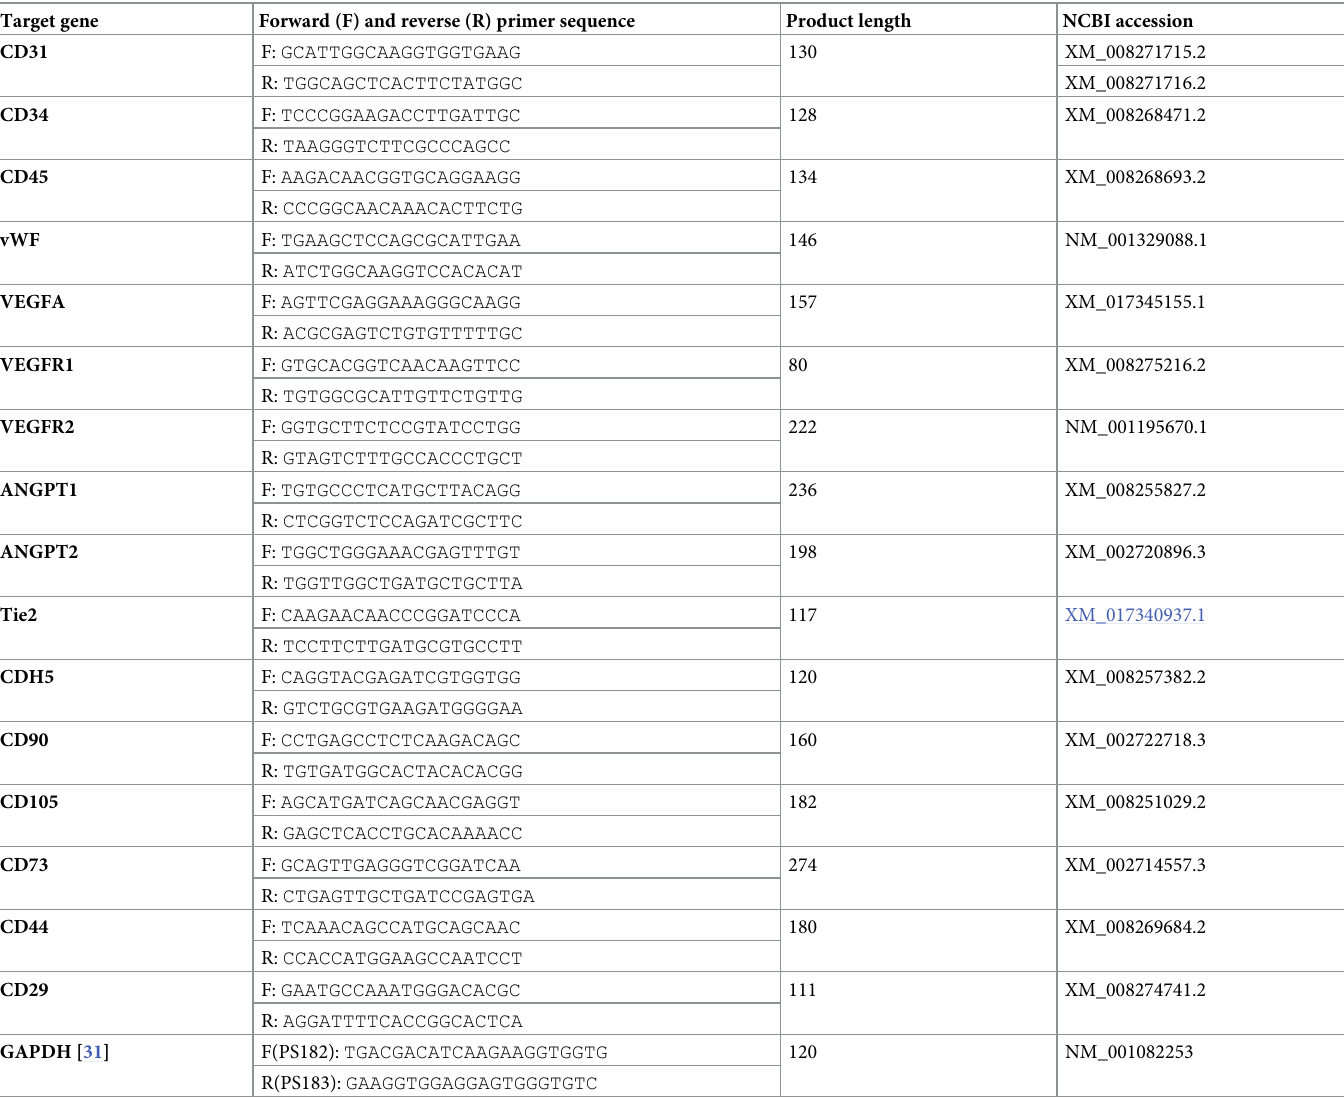
Table 1. Primer pairs for quantitative RT-PCR analysis of target rabbit genes. Target gene Forward (F) and reverse (R) primer